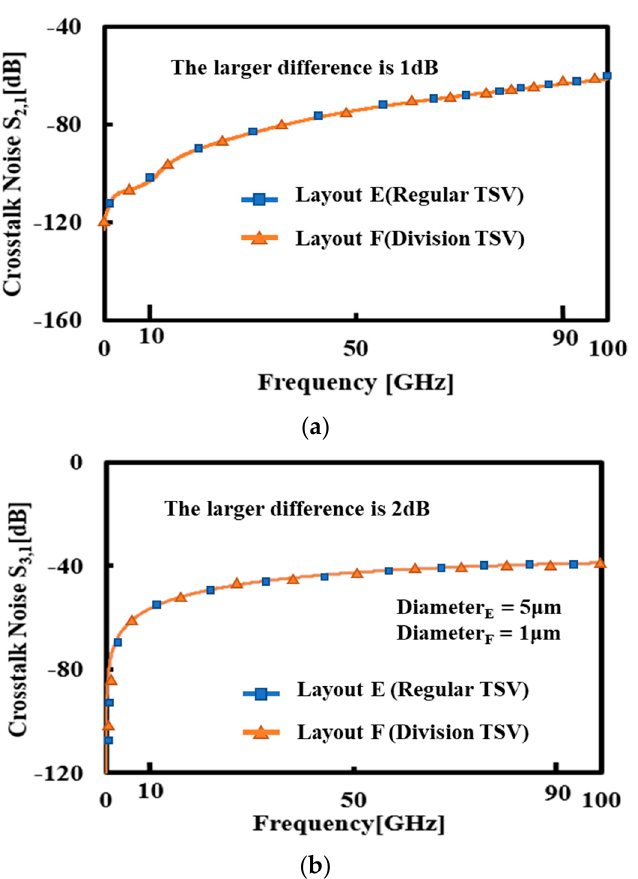
Figure 13. The crosstalk noises between layout E and layout F. ( a ) crosstalk noise S2,1 of layout E and layout F; ( b ) crosstalk noise S3,1 of layout E and layout F.